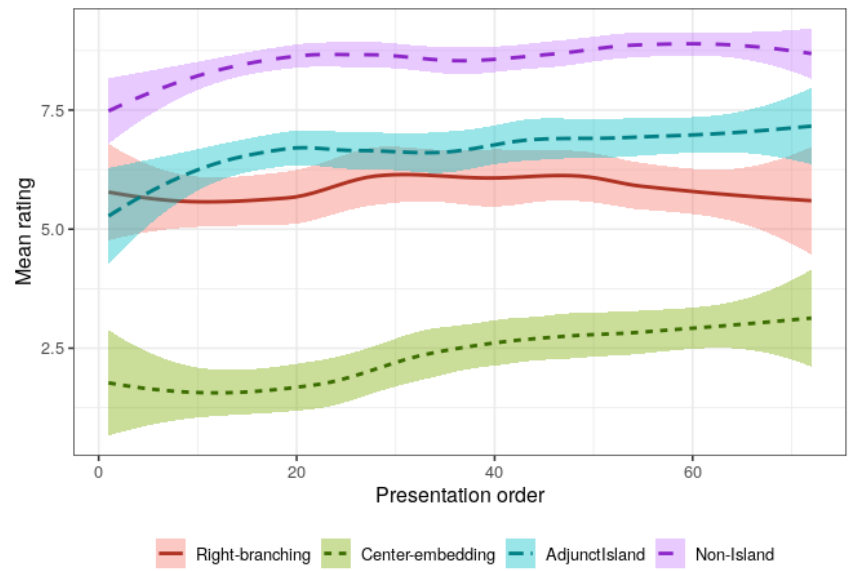
Figure 1. Differential effect of repeated exposure in Hofmeister (2015).